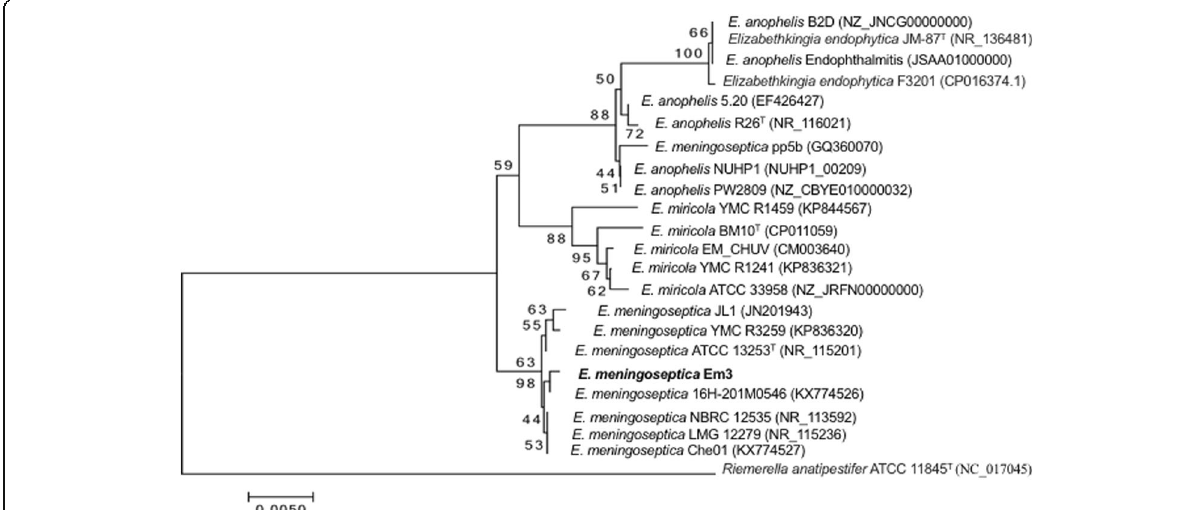
E. meningoseptica Em3, E. meningoseptica 16H-201 M0546 (KX774526), E. miricola YMC R1459 (KP844567), E. miricola BM10 T (CP011059), E. miricola